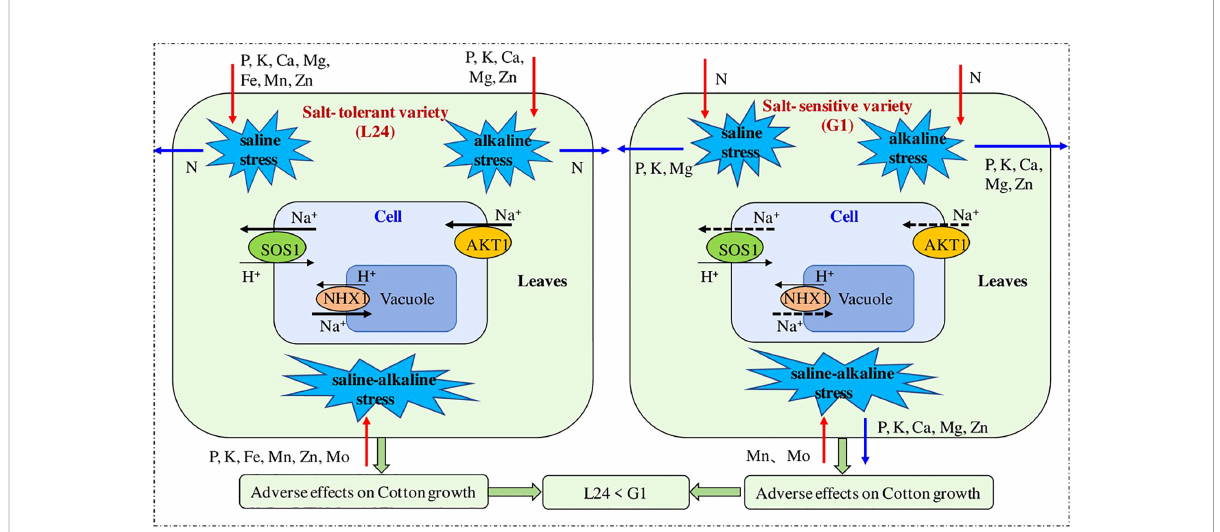
FIGURE 4 A study showing the comparison between a salt tolerant and salt sensitive cultivar in terms of response of ion content and gene expression (Sun et al., 2021)